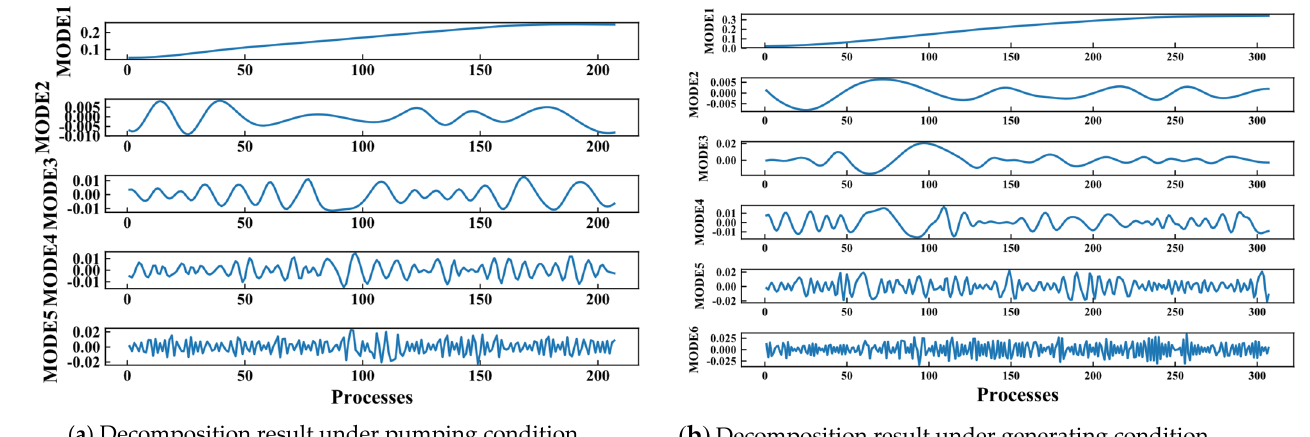
Figure 13. Decomposition result of PDI sequences by EMD.